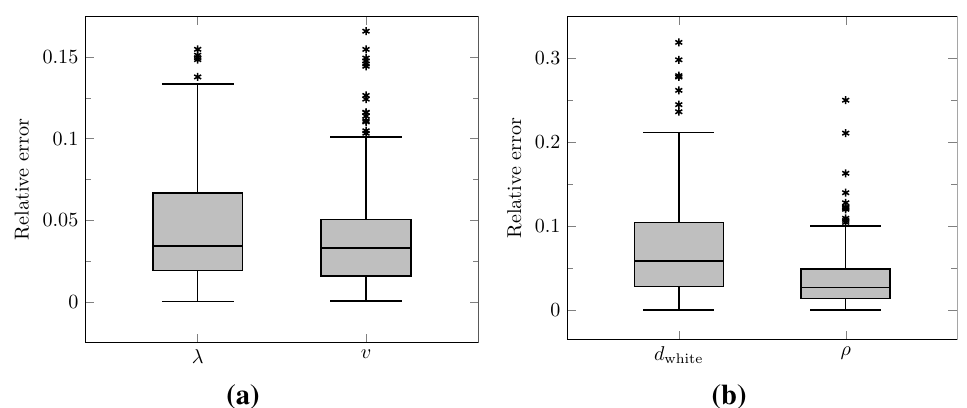
Figure 10. Boxplots of the relative error on the predicted model parameter values evaluated on the test set. ( a ) Relative errors on the estimated values of λ and v provided by the second network (Figure 6). ( b ) Corresponding relative errors on the derived values of d white and ρ using Equations (12) and (13). Horizontal line: median, box: interquartile range, whiskers: ± 1.5 interquartile range, asterisks: outliers.